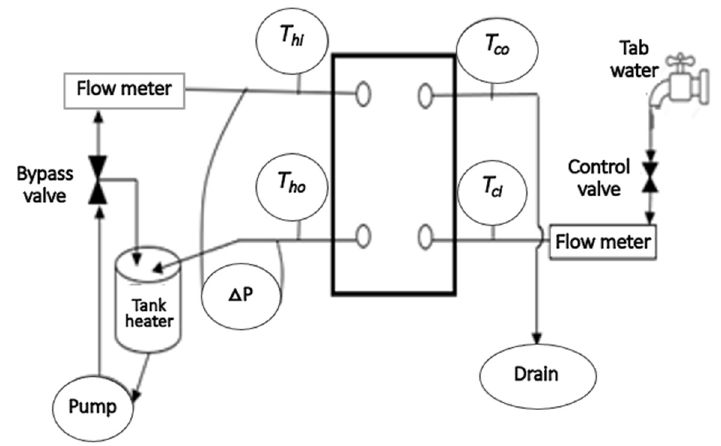
Figure 3. A flow diagram of the setup used for the experimental investigation.